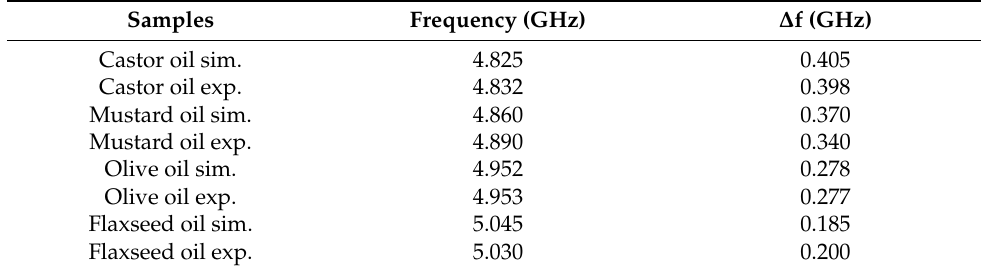
Figure 4. Result of S 21 for: ( a ) castor and flaxseed oils; ( b ) mustard and olive oils. A comparison of the shift in resonant frequencies from the reference frequency of 5.25 GHz after the loading of the oil sample, is provided in Table 1. The shift in the frequency was proportional to the permittivity of the OUT. Table 1. Comparison of shift in frequency for oil samples.